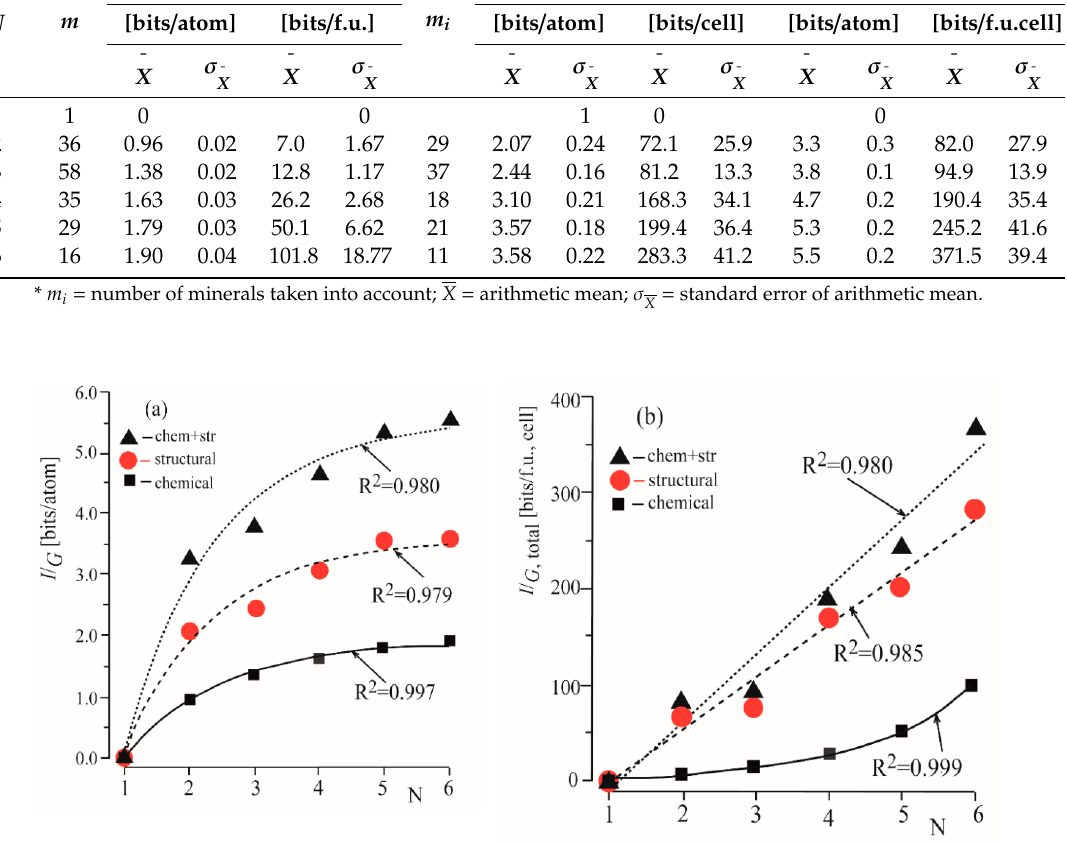
Figure 4. Dependence of chemical, structural, and crystal–chemical complexities of tellurium minerals on the number of species-defining chemical elements ( N ). The complexity per atom ( a ) and per unit cell or per formula unit ( b ).